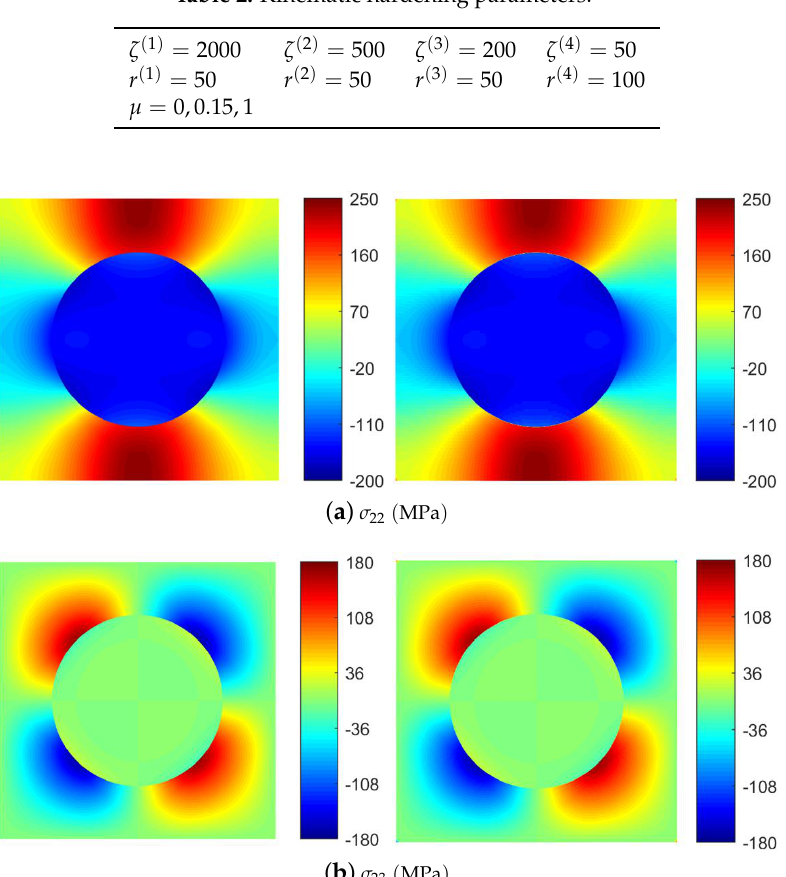
Figure 4. Comparison of selected local stress distributions after thermal cooldown temperature of ∆ T = − 550 ◦ C: FEM (left); FVDAM